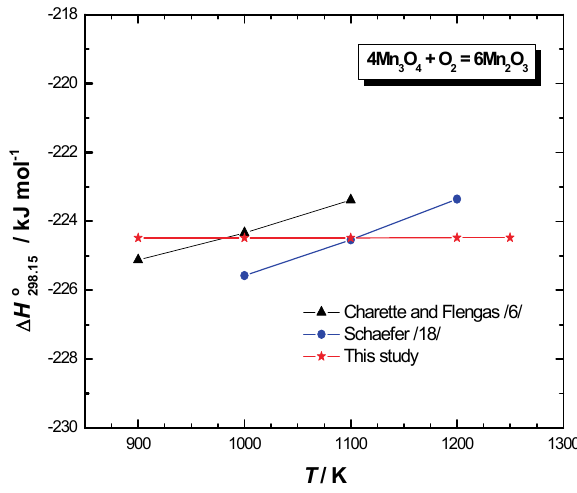
Figure 8. Results of “third-law” analysis of Gibbs energy of formation of Mn 2 O 3 from Mn 3 O 4